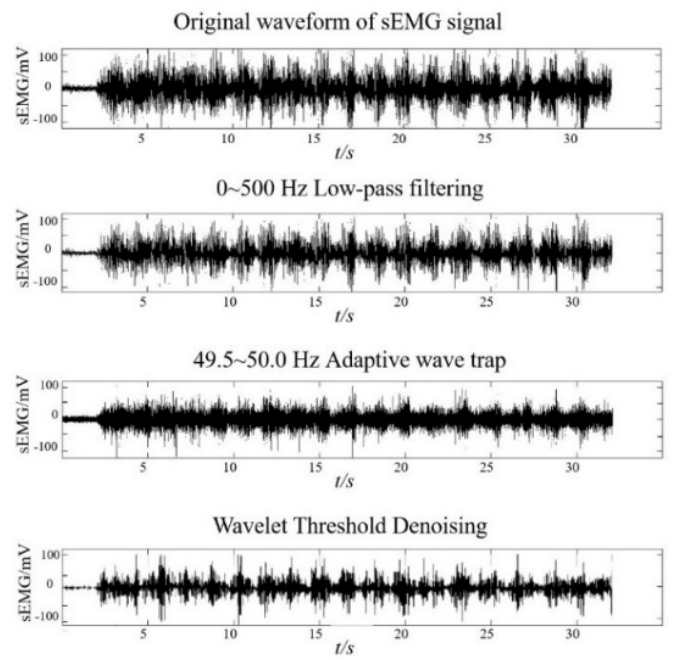
Figure 3. Time domain diagram of sEMG signal pre-processing process.